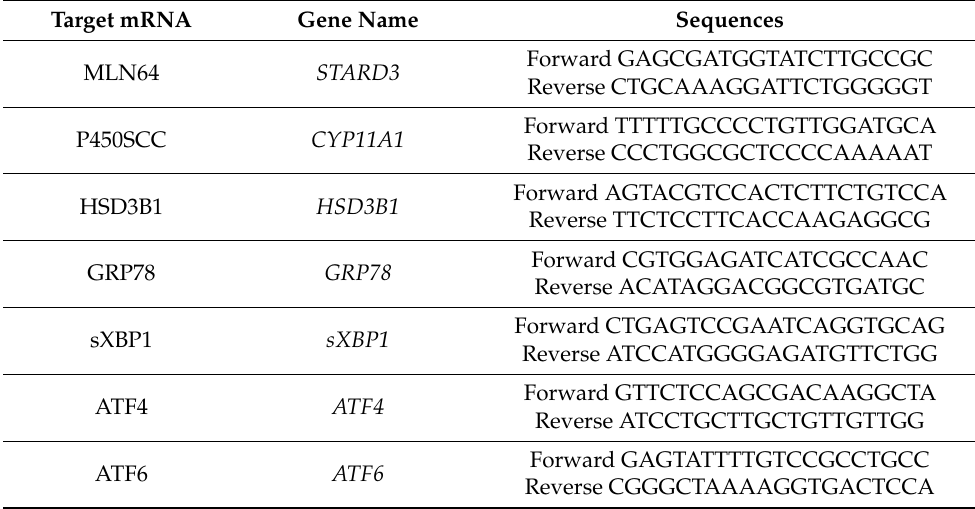
Table 2. Sequences of primers used for